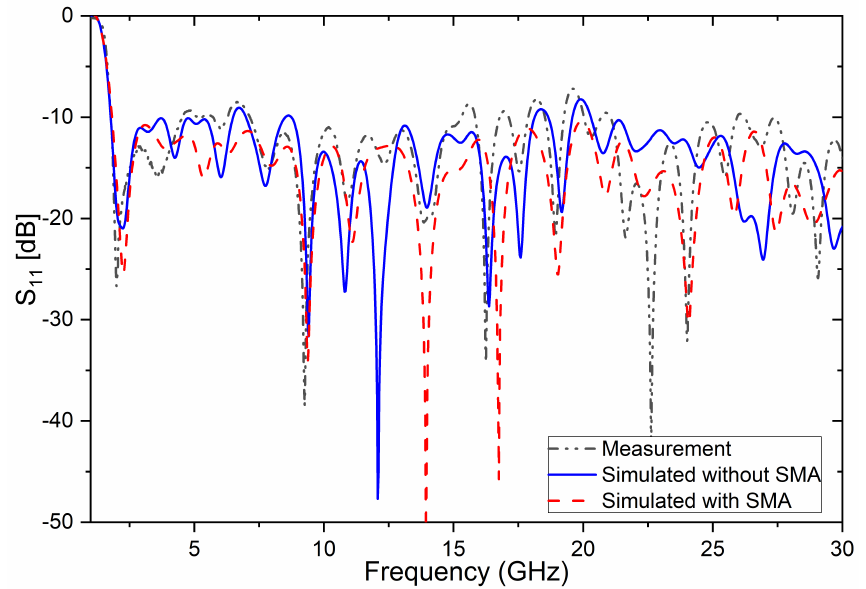
Figure 11. Comparison of the measured and simulated reflection coefficients of the antenna with and without SMA